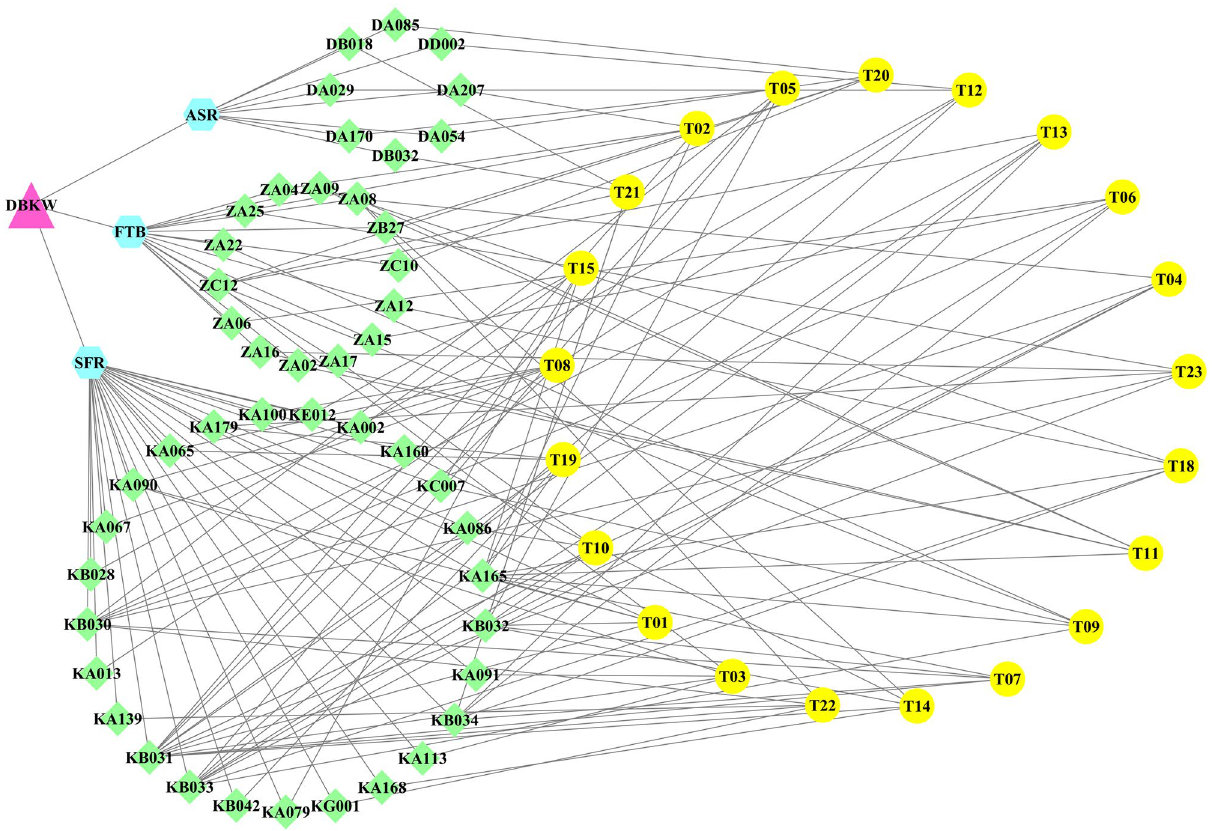
Figure 5. Network of the formula, herbs, chemical compounds and targets. ASR Angelicae Sinensis Radix, DBKW Danggui Beimu Kushen Wan, FTB Fritillariae Thunbergii Bulbus, SFR Sophorae Flavescentis Radix. For corresponding compound names, refer to Supplementary Tables S1 to S3 online; for corresponding target names, refer to Table DA175, DB019, ZF04, DA012, DB004, DB005 and DB024. Additionally, seven compounds were predicted as inhibitors of PTGS2 with moderate probability, including DA053, DA108, DA134, DA153, DA164, DA175 and